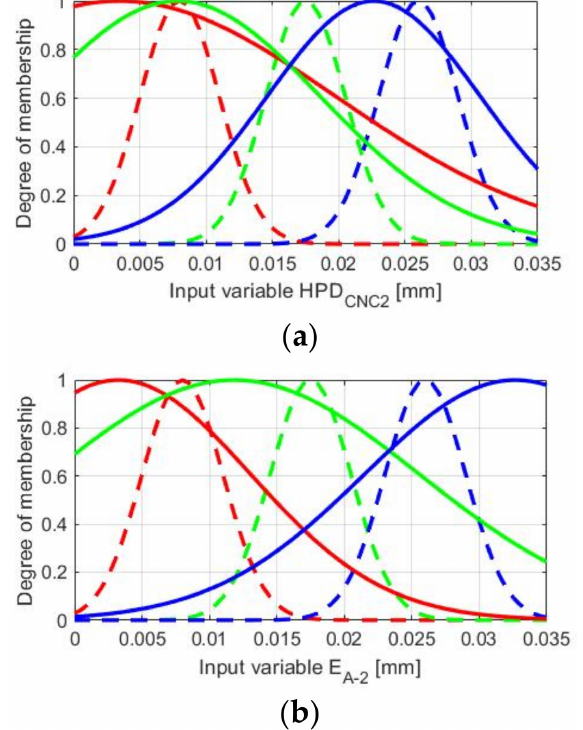
Figure 12. Membership functions before and after the training process: ( a ) for the first input variable HPDCNC2; ( b ) for the second input variable E A − 2 . Dashed lines refer to the shape of the sets before the training phase; solid lines refer to the shape of the sets after the training phase. Fuzzy set no. 1—red curve; fuzzy set no. 2—green curve; fuzzy set no. 3—blue curve.